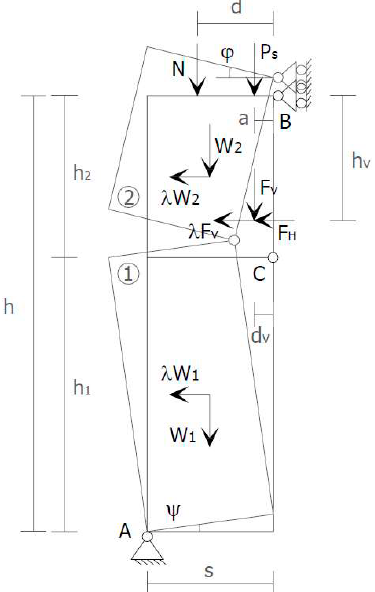
Figure 2. Failure mechanism for the hammering action of a floor when an upper kerb retains the wall. The internal hinge makes the system a labile scheme.